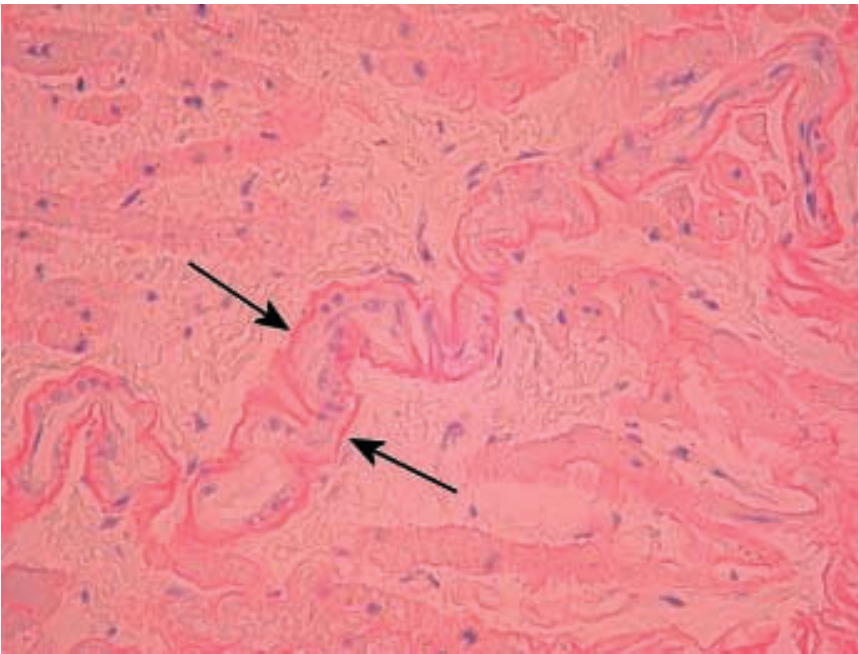
Endo-myocardial biopsy showing a homogenous acel- lular eosinophilic in- filtration, positive for Congo red staining, confirming cardiac infiltration in sys- temic amyloidosis, especially in the perivascular contour